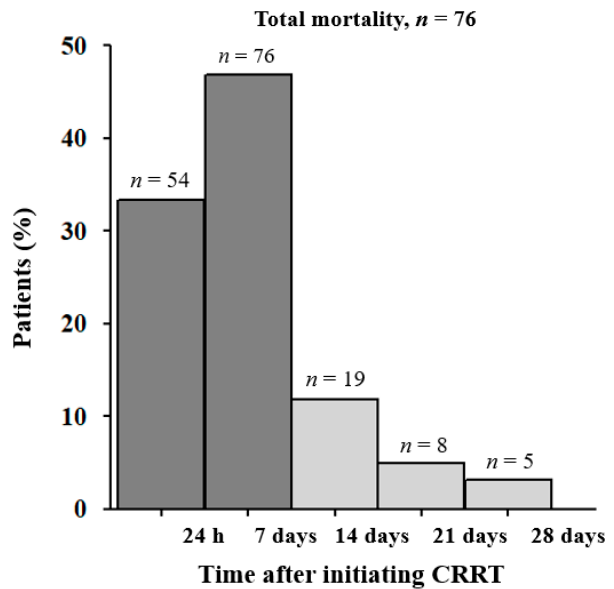
Figure 1. Mortality rate according to time after continuous renal replacement therapy (CRRT) initiation. By univariate logistic regression analysis, patients with MAP < 65 mmHg and SIRS had an odds ratio (OR) of 2.436 (95% CI; 1.206–4.922, p = 0.013) and OR of 2.096 (95% CI; 1.054–4.168, p = 0.035) for